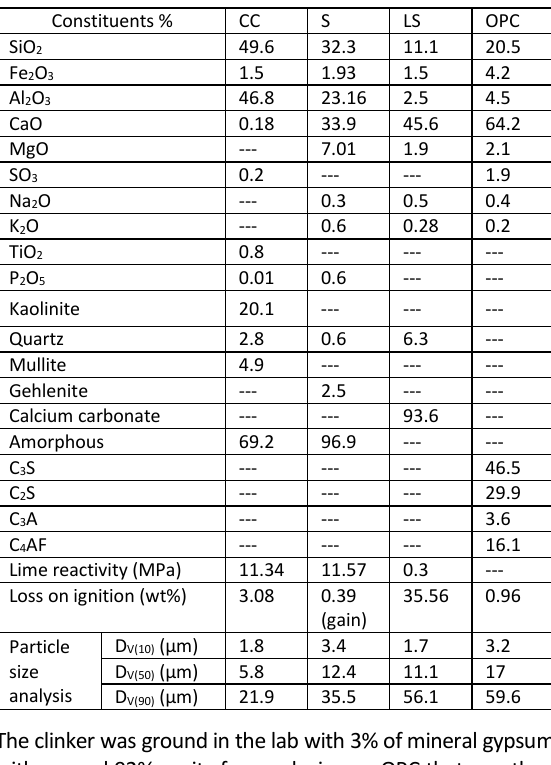
Table 1. The physical and chemical properties highlight the key differences between CC and slag, such as the alumina content and fineness. The reactive alumina in clay and slag was calculated using XRF and XRD data [25]. The alumina in crystalline unreactive phases (such as kaolinite, mullite, etc.) was subtracted from the total Al 2 O 3 obtained from the XRF data. The total amorphous alumina in clay was around 35% and in case of slag was around 22%. Despite having a difference in phase composition and fineness, the lime reactivity values were found to be similar [20, 26]. Table 1. Chemical compositions and physical properties of SCMs and the OPC used.